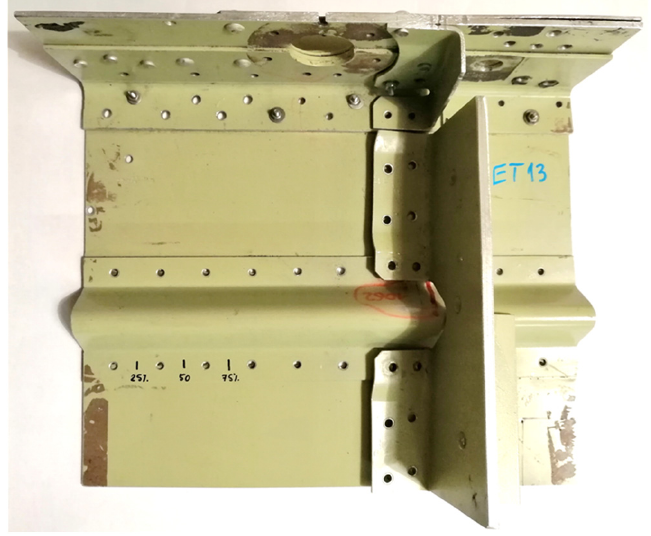
Figure 10. Photo of the airplane sample used in the initial experiments.